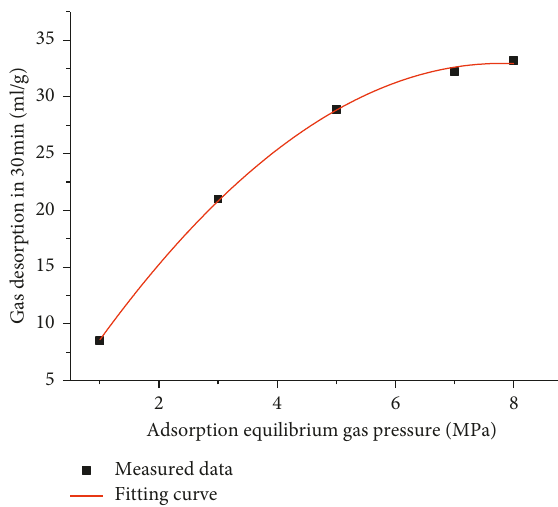
Figure 7: Curve of the gas desorption amount per unit mass in 30min versus the moisture content.